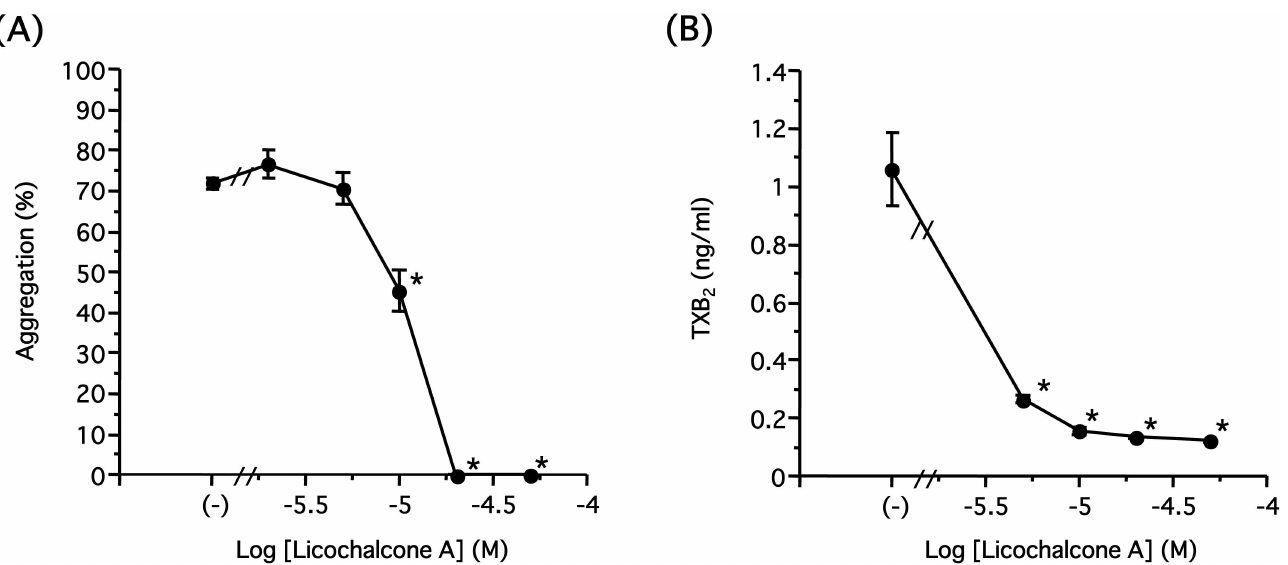
Fig 5. Concentration-dependent inhibition of arachidonic acid metabolism by licochalcone A. (A) Licochalcone A (2–50 μ M) or DMSO ( − ) was preincubatedfor 5 min before additionof arachidonic acid (30 μ M) in the presence of 1 mM CaCl 2 . Results are shown as mean ± S.E.M. ( * P < 0.05 comparedwith control, n = 3, Dunnett’s method). (B) Licochalcone A (5–50 μ M) or DMSO ( − ) was preincubated for 5 min before additionof collagen (3 μ g/ml) in the presenceof 1 mM CaCl 2 , and terminated by EDTA/indomethacinafter incubating for 5 min. Samples were diluted1/1000 and TXB 2 amount was measured by EIA. Results are shown as mean ± S.E.M.( * P < 0.05comparedwith control, n = 3, Dunnett’s method).